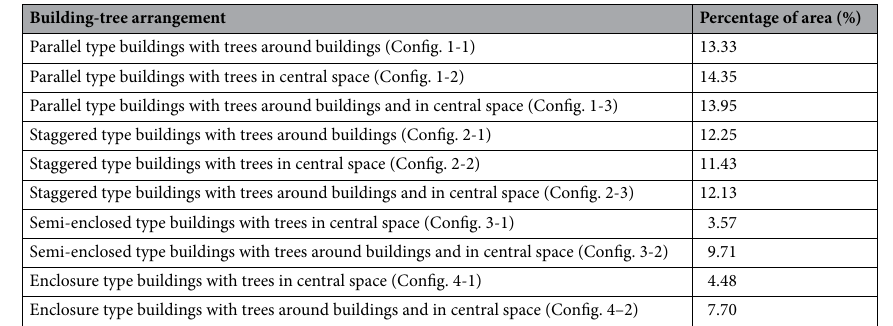
Table 3. Percentage area with PM 2.5 concentration over 75 μg/m 3 in each